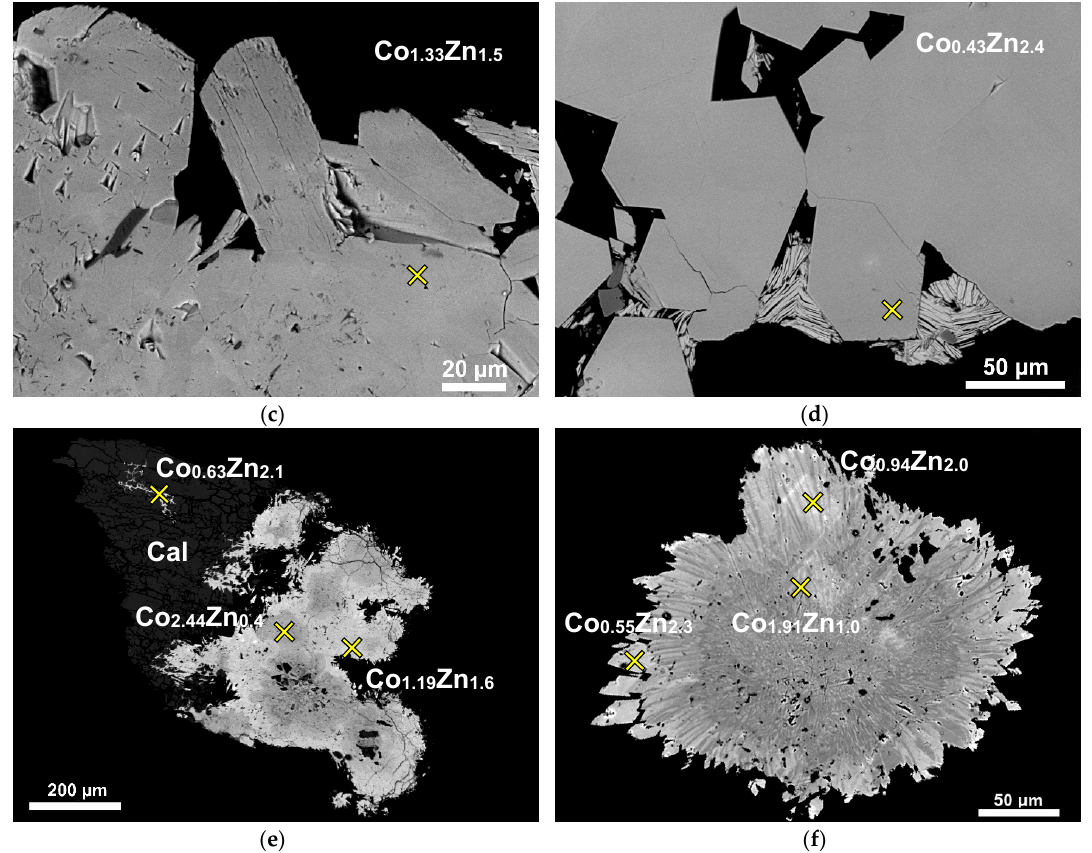
Figure 4. Back-scattered electron (BSE) images showing the spatial relationships between compositionally di ff erent members of the erythrite–köttigite solid solution in Miedzianka. ( a ) Radial aggregate of erythrite. ( b ) Prismatic crystals of Zn-rich erythrite. ( c ) Crystals with intermediate composition between köttigite and erythrite. ( d ) Unidentified Zn-anhydrous arsenate occupies the space between prismatic köttigite crystals. ( e , f ) Zoned aggregates of the erythrite- köttigite crystals. The outer portions of the aggregates are enriched in Zn (EPMA). Chl—chlorite; Qz—quartz; Cal—calcite. EPMA spots are marked with